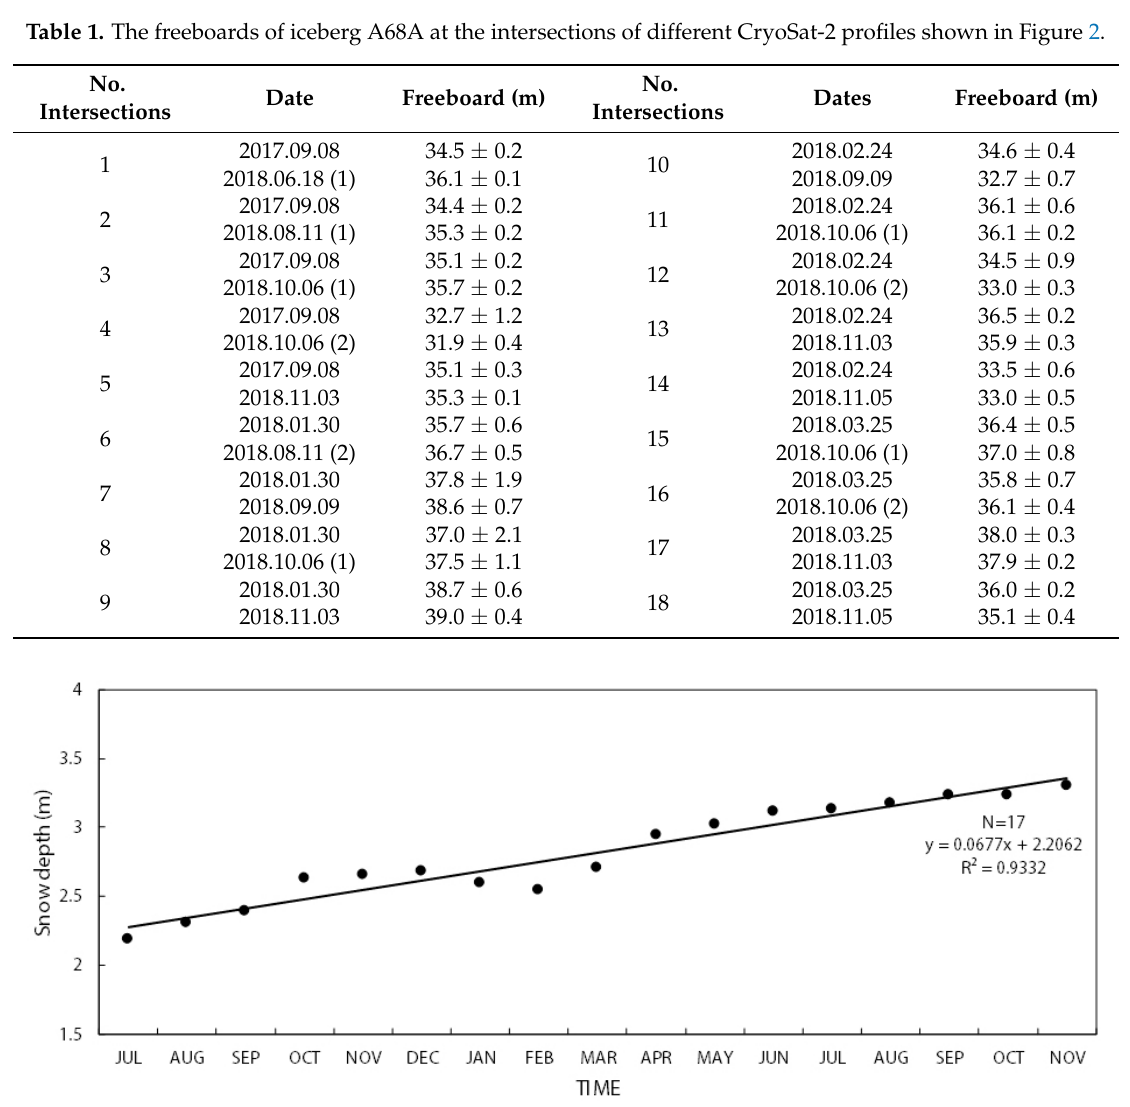
Figure 6. Monthly averaged snow depth on glaciated area around iceberg A68A predicted by the MERRA-2. N is the number of data points.